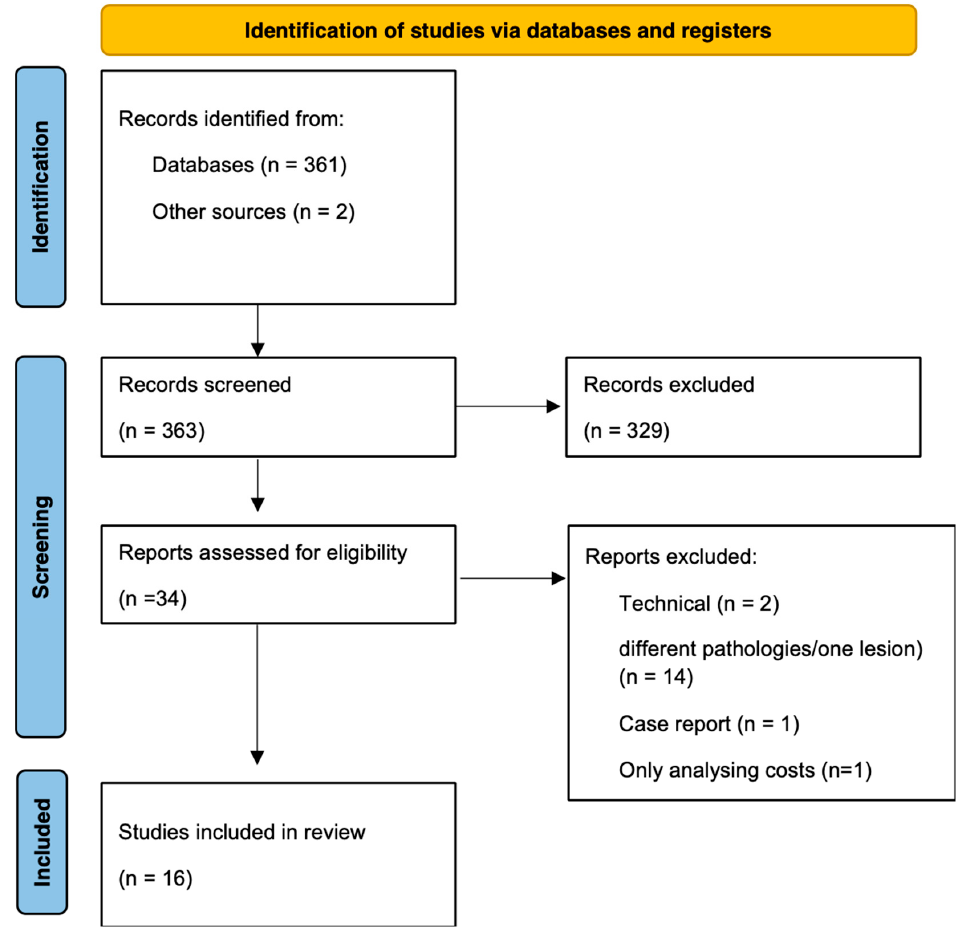
Figure 2. PRISMA flow chart for the review showing the process of the study selection.